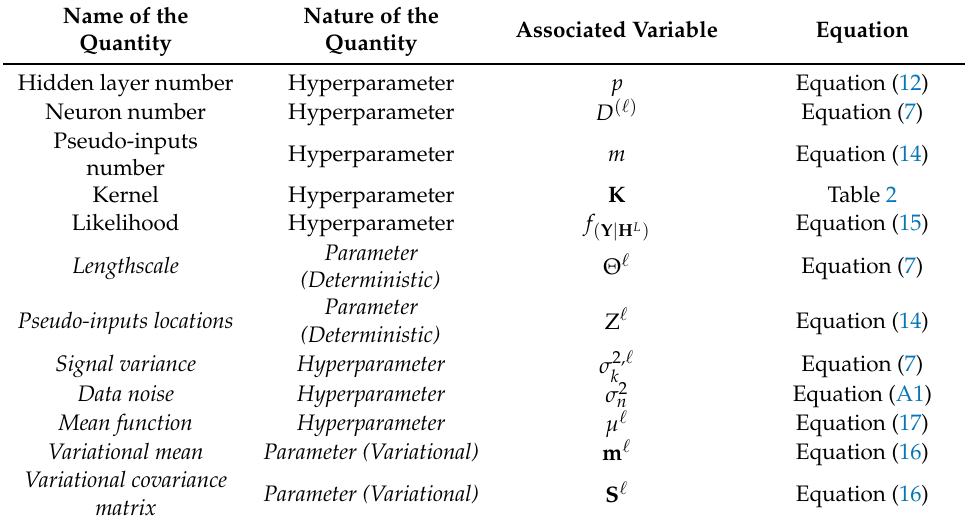
Table 6. DGP parameters and